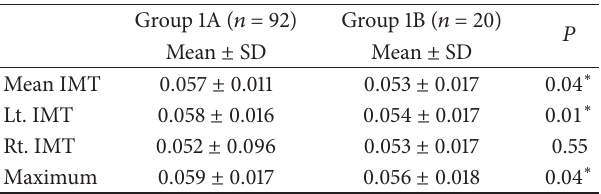
Table 7: Comparison of ultrasonographic duplex findings in RA patients.